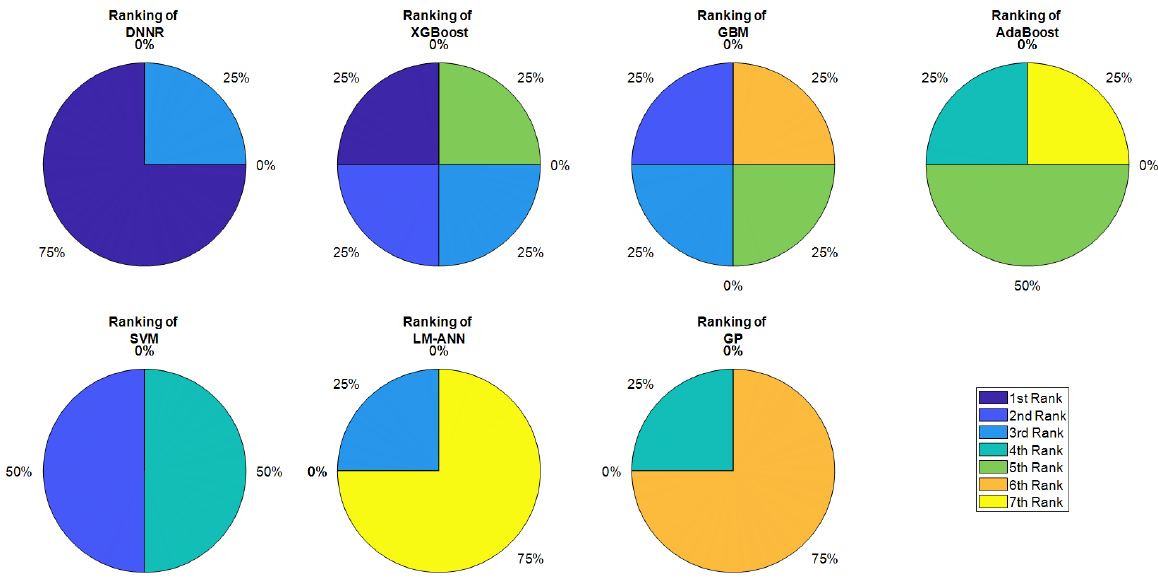
Figure 5. Summary of the models’